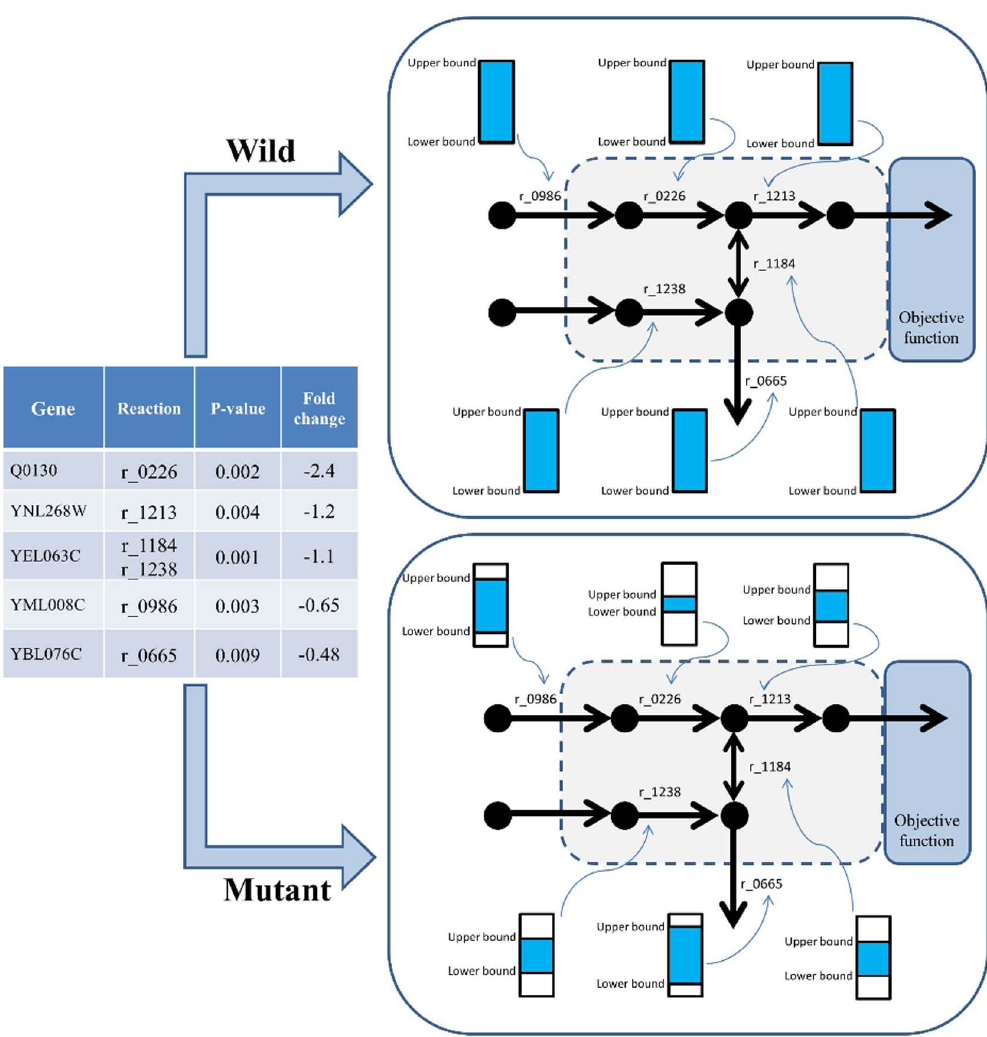
Figure 1. This figure is a schematic workflow of our method for GSMM construction. The significant down-regulated gene ( p-value , 0.01) and the corresponding reactions (according to GPR) were determined. (In this model, 5 genes and 6 reactions were identified). Afterward, we have restricted the fluxes of the given reactions according to their fold change values. For example if the fold change value is 2 2, we have restricted the upper bound and lower bound of the corresponding flux to one quarter of the corresponding WT.